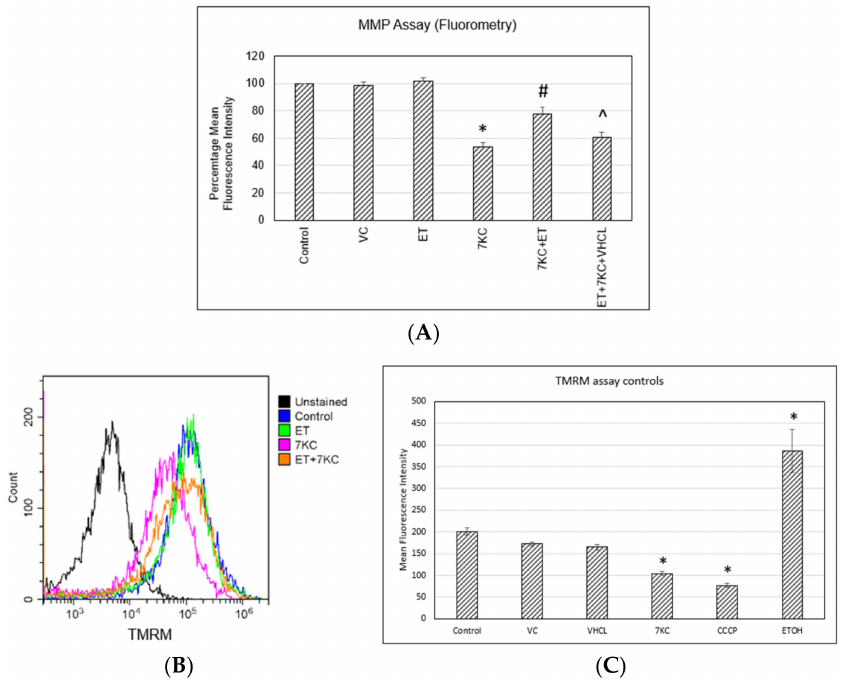
Figure 5. Mitochondrial membrane potential assays. 7KC was found to significantly increase